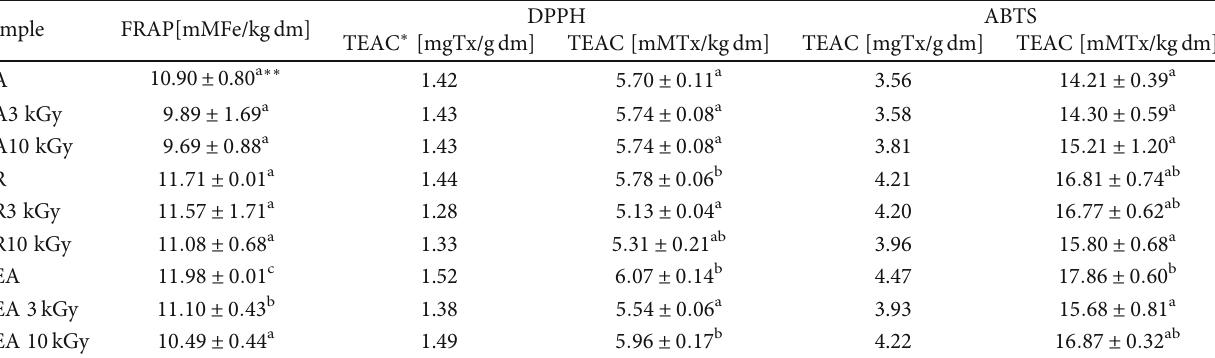
Table 3: Antiradical activity (measured by DPPH and ABTS methods) and antioxidative properties of rye varieties grain before and after irradiation.